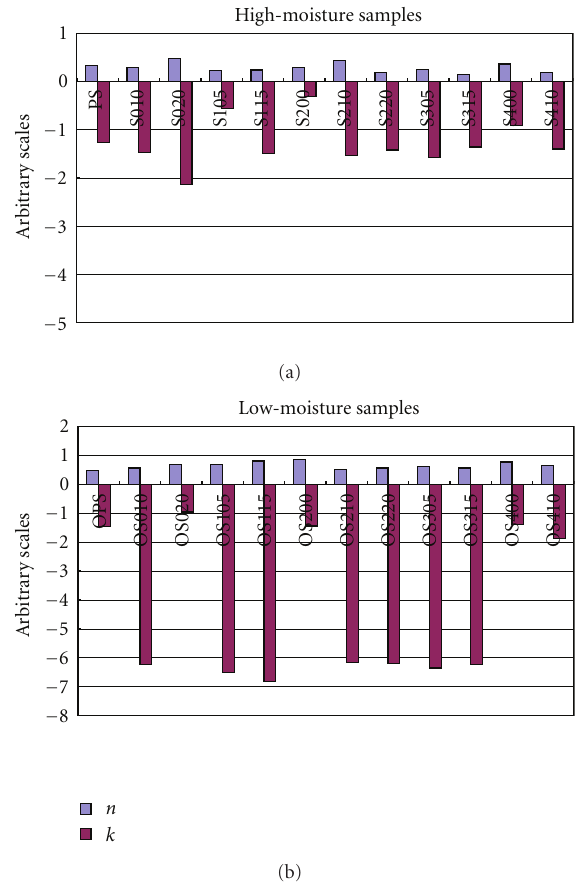
Figure 9: A barchart of the exponent n and the factor k obtained from a nonisothermal crystallization analysis. The x -axis represents the concentration of nanoclay and sorbitol only , without their prefix letter for